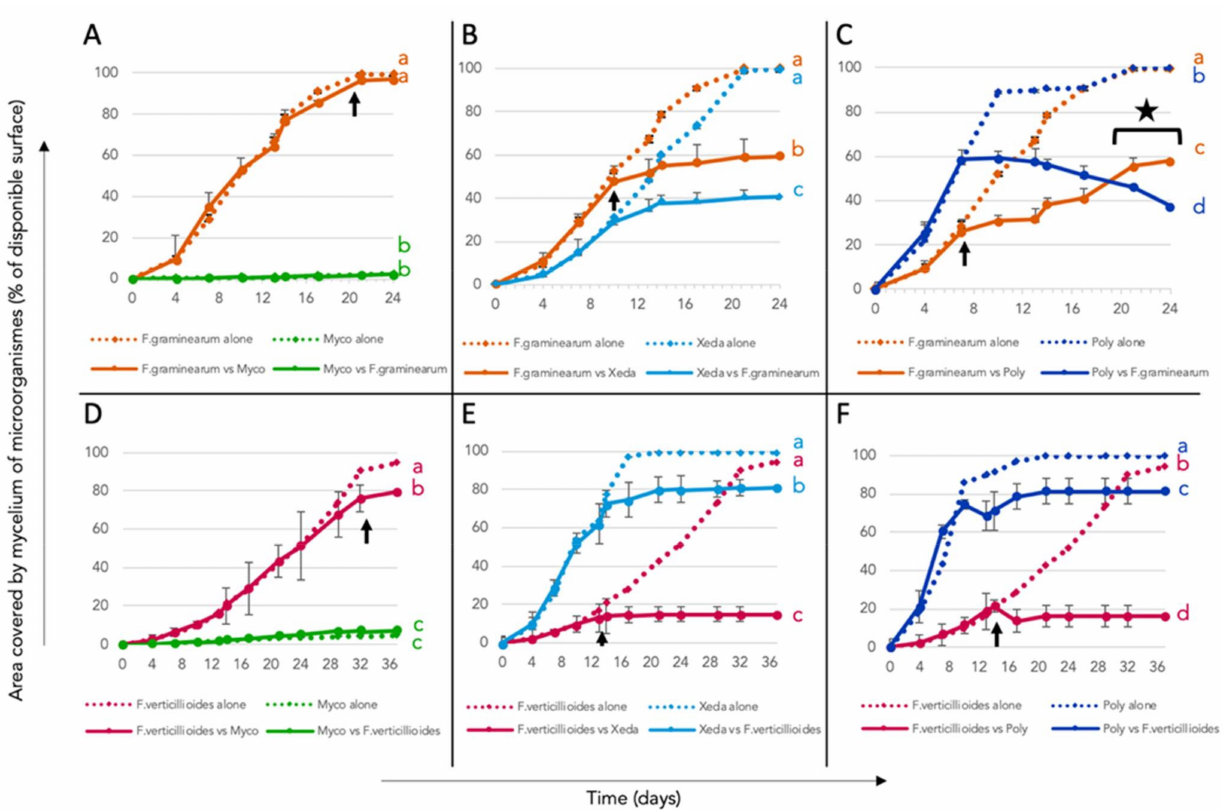
Figure 10. Spatial competition between BCAs and pathogens. ( A – C ): CYA medium nonlimiting with F. graminearum in competition against Myco, Xeda and Poly, respectively, or each one alone, during 25 days at 25 ◦ C. ( D – F ) PDA medium nonlimiting with F. verticillioides in competition against Myco, Xeda and Poly, respectively, or each one alone, during 40 days at 25 ◦ C. Arrow indicates first contact between BCA and pathogen and star indicates overgrowth of BCA on pathogen colony; on confrontation curves. Myco: Mycostop ® , Xeda: Xedavir ® , Poly: Polyversum ® . ANOVA test independent for each competition modality on area under the growth curves (AUGCs), p -value <